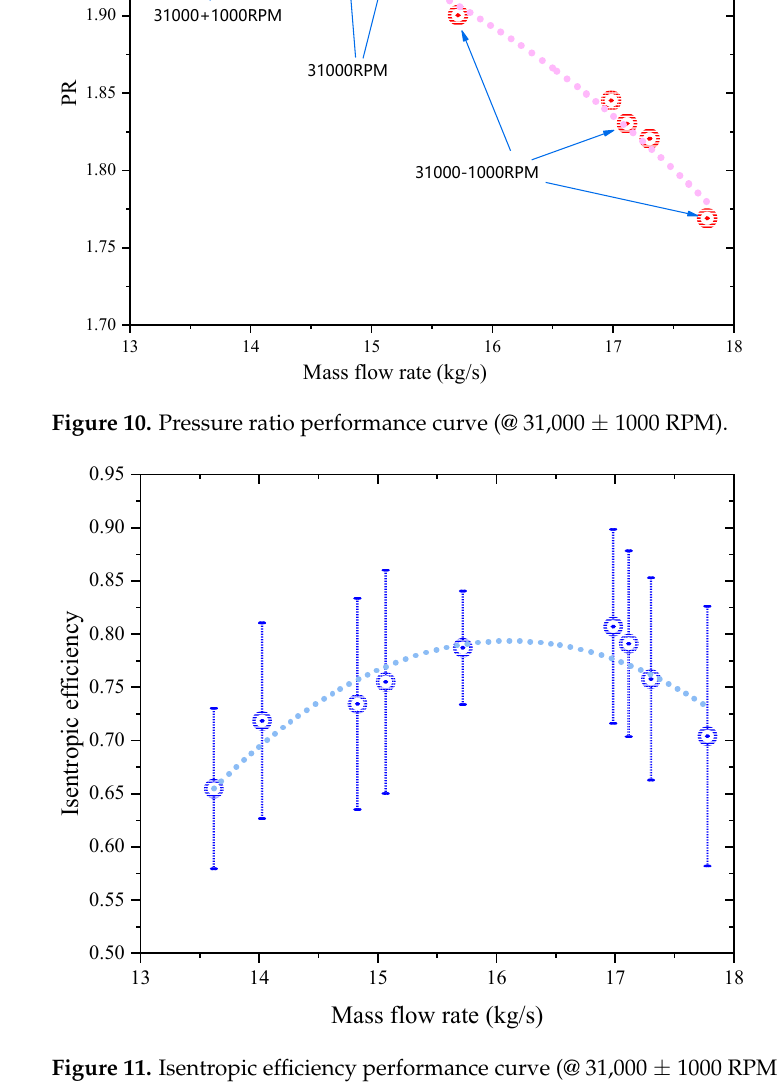
Figure 10. Pressure ratio performance curve (@ 31,000 ± 1000 RPM).